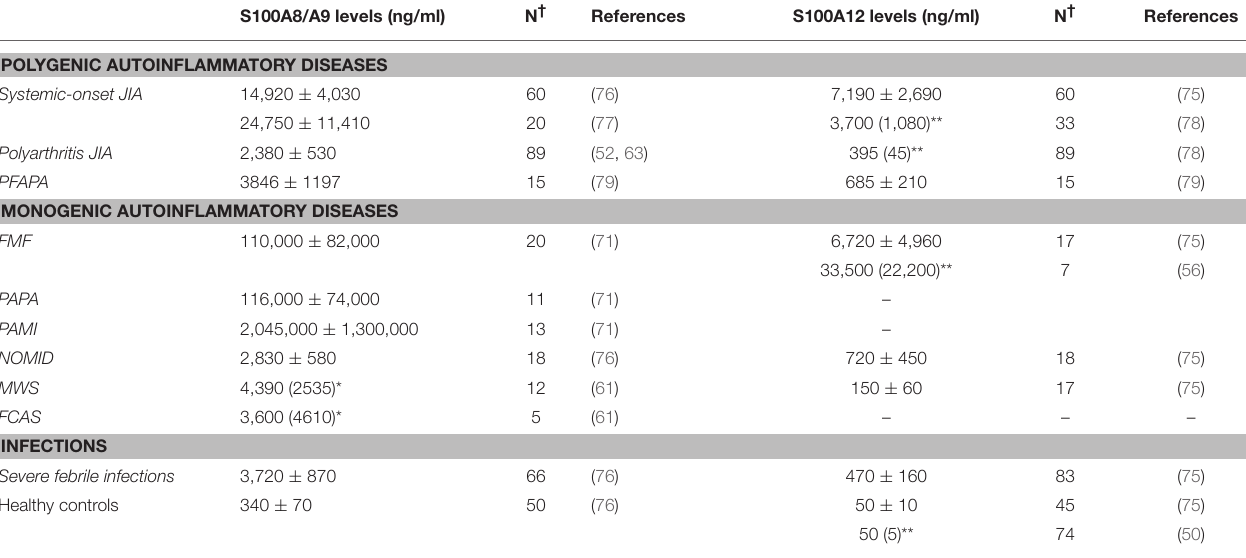
TABLE 1 | Serum concentration of phagocyte-specific S100 proteins in inflammatory diseases [adapted and updated from Kessel et al.